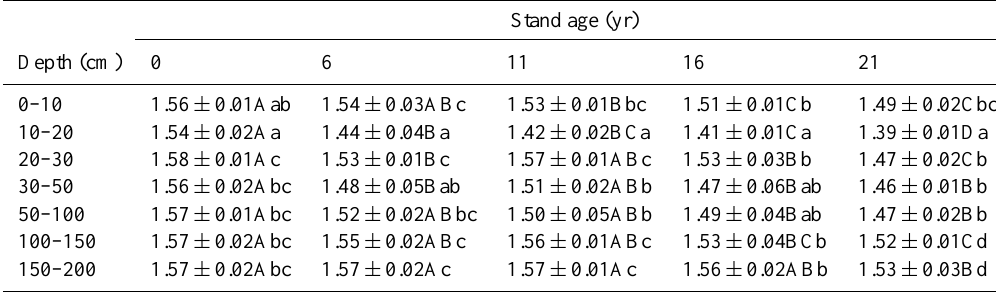
Table 1. Soil bulk density (gcm − 3 ) in different stand ages at different soil depth.